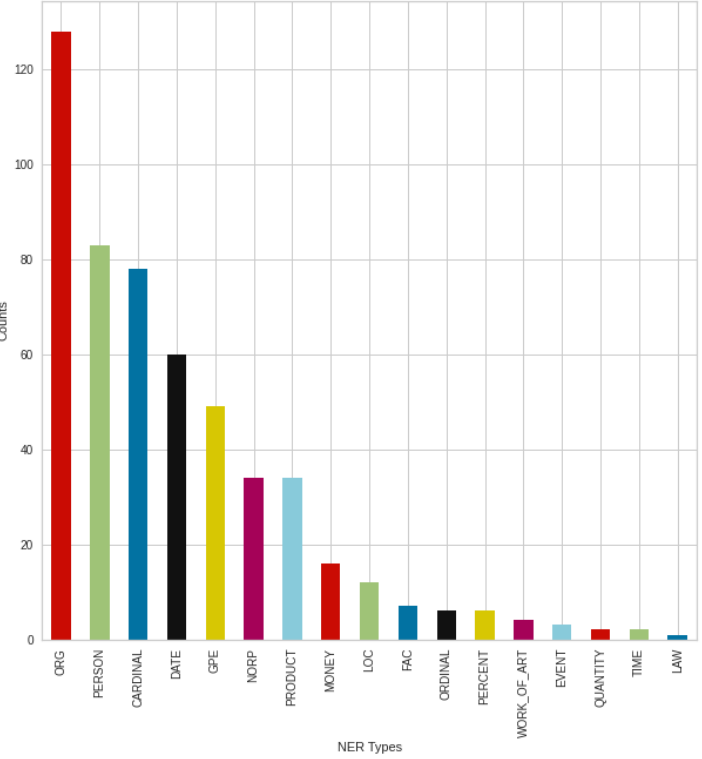
Figure 18. NER types of the negative tweets. The time period stands between 2 September 2021